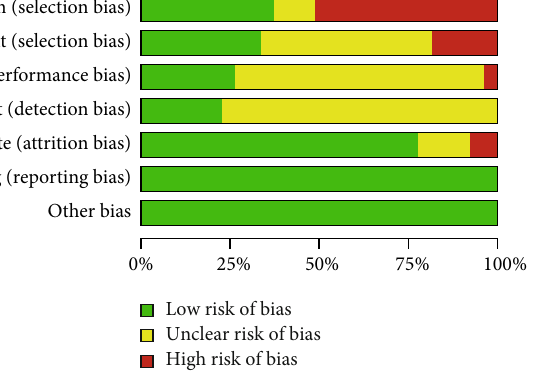
Figure 2: Risk of bias assessment.